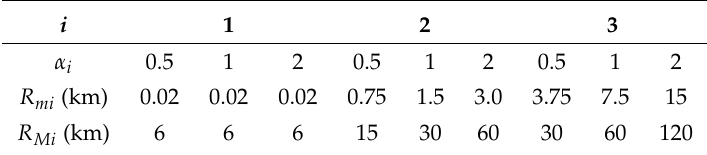
Table 7. Main control parameters.